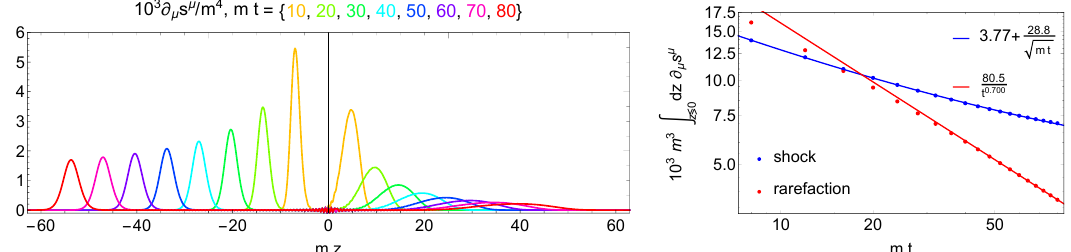
Figure 14: We show the divergence of the entropy current for several times (left) as well as the integral over the left (shock, blue) and right (rarefaction, red) re- gions (right). The entropy production in the shock settles down to a constant value, whereas for the rarefaction wave the entropy production decays to zero in a power- law fashion.